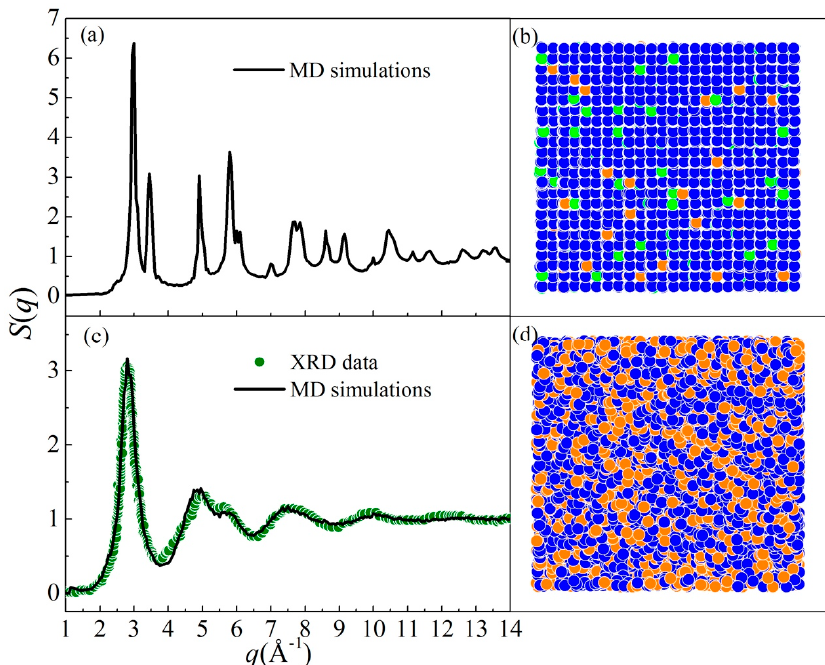
Figure 3. The structure factor ( S ( q )) and projection of atomic positions for ( a , b ) the crystalline state (Ni 90 Zr 5 Mo 5 ) and ( c , d ) the amorphous state (Ni 64 Zr 36 ), respectively [56]. The XRD data [73] for Ni 64 Zr 36 MGs are also presented and marked as olive dots. Blue solid circles are for Ni, orange solid circles for Zr, and yellow solid circles for Mo.